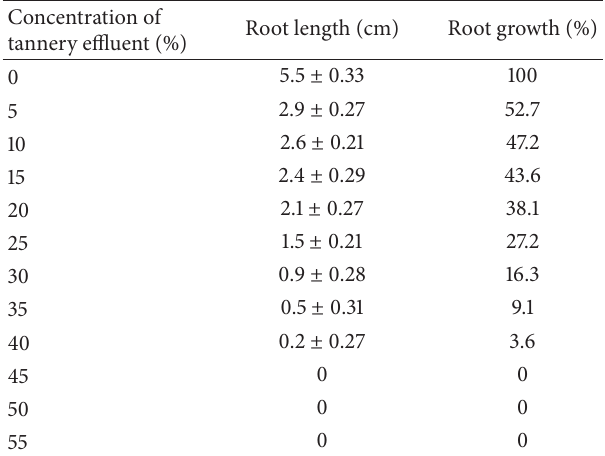
Table 1: Physicochemical characteristics of the tannery effluent collected from Palar River (all values are mean range for three observations each).